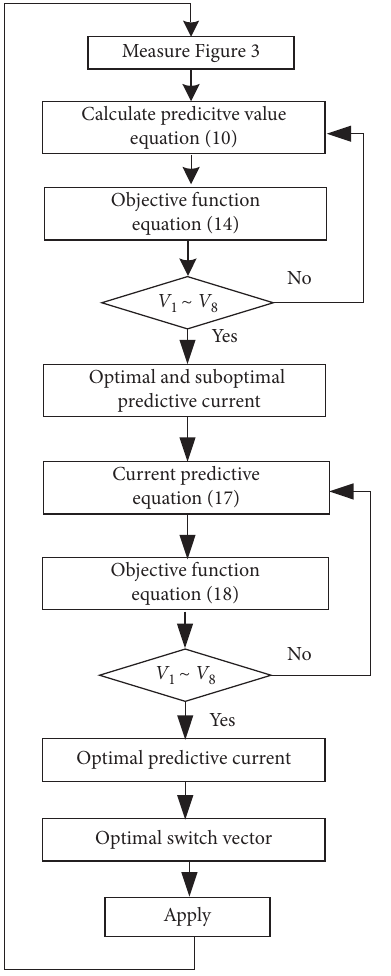
Figure 7: Multistep FCS-MPC